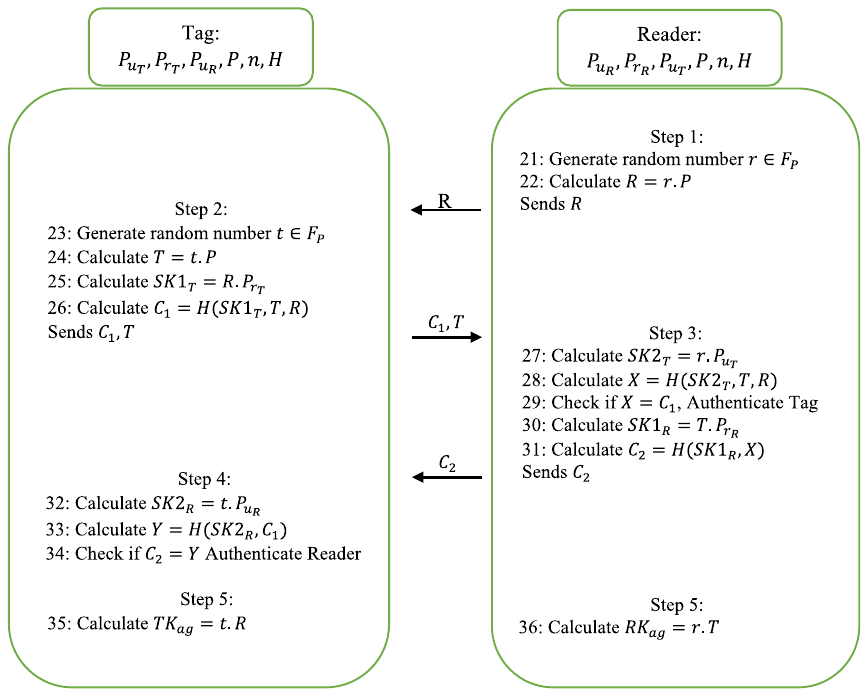
Fig. 2 The proposed authentication